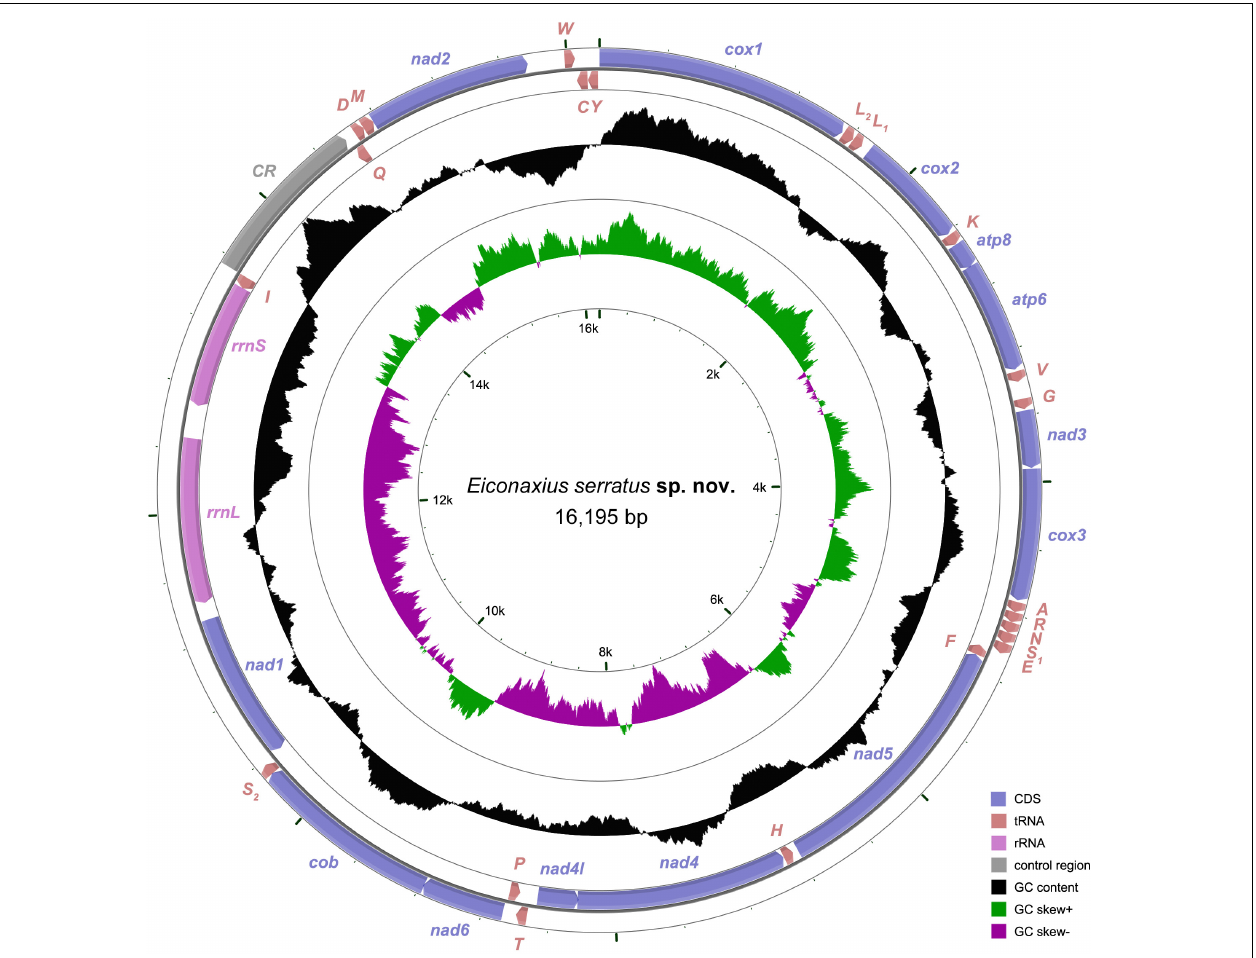
FIGURE 7 | The organization of the mitochondrial genome of Eiconaxius serratus sp. nov . The full names of protein coding genes, rrnS and rrnL, are listed under abbreviations rrnS and rrnL, 12S and 16S ribosomal RNA genes, respectively; atp6 and atp8, ATPase subunit 6 and 8 genes, respectively; cox1–cox3, cytochrome c oxidase subunits I–III genes, respectively; cob, cytochrome b gene; nad1–6 and 4l, NADH dehydrogenase subunit 1–6 and 4l genes, respectively. One uppercase letter amino acid abbreviations are used to label the corresponding tRNA genes. The position of control region (CR) is indicated in the figure.